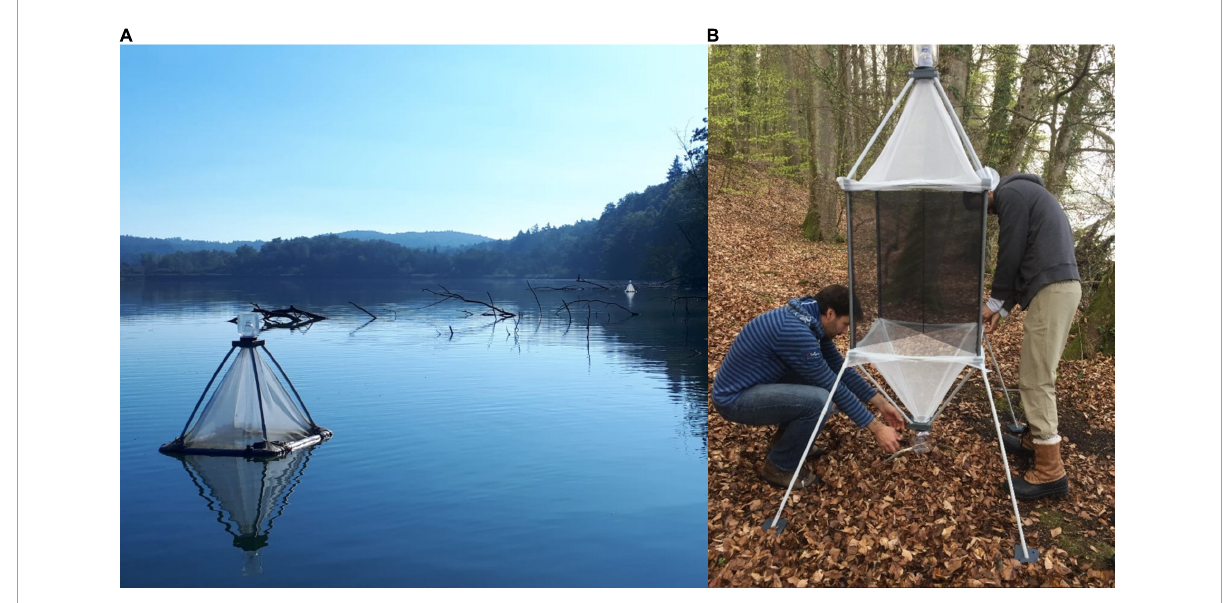
FIGURE1 (A) Emergence traps floating on Lake Mindelsee deployed in two transects at the water surface with water depths of 1, 3, 7, 9, and 12 m and (B) Malaise/window hybrid traps deployed in two transects at 1, 100, and 1,000 m from the shoreline.